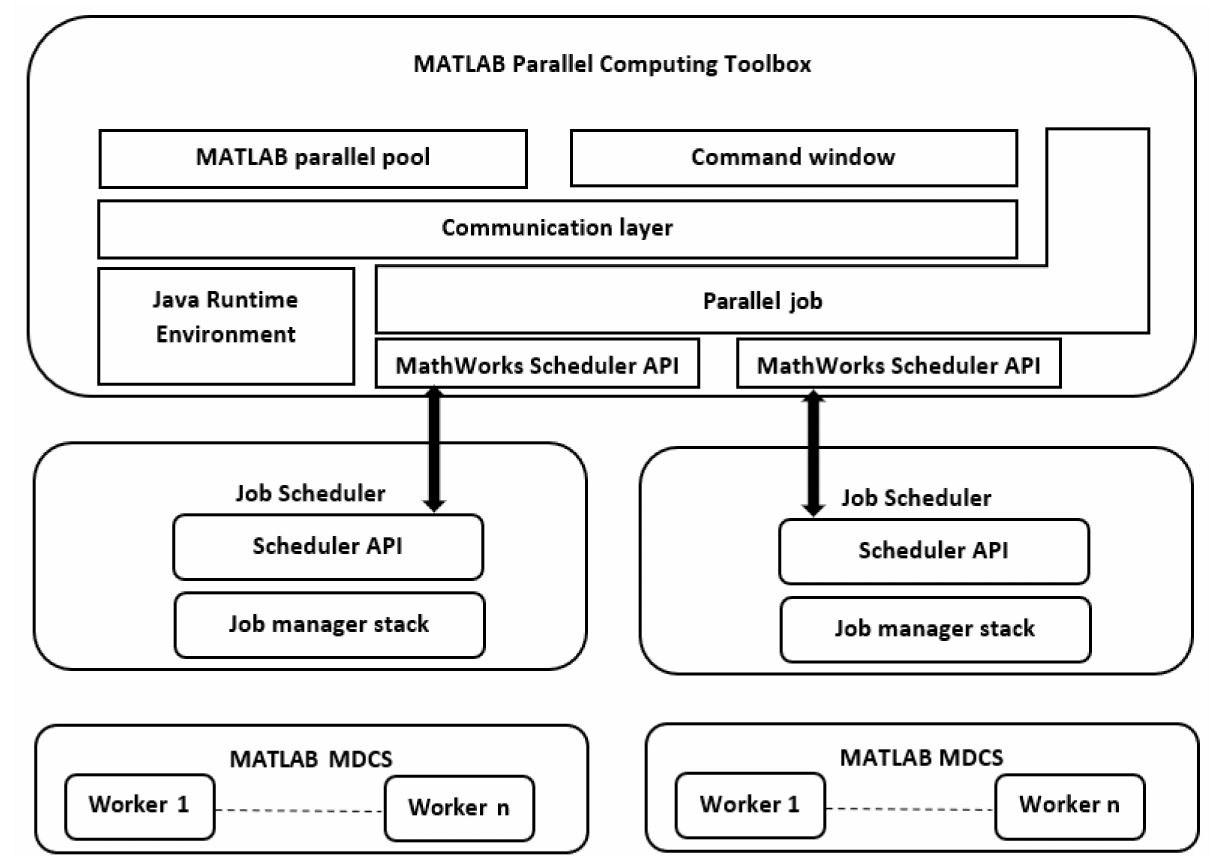
Figure 5. Parallel computing software stack in